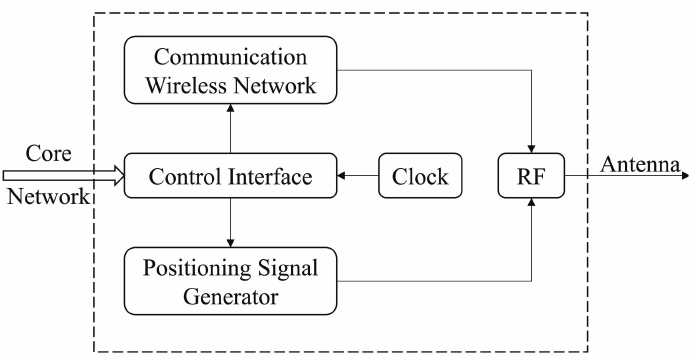
Figure 1. The structure of the CPIS base